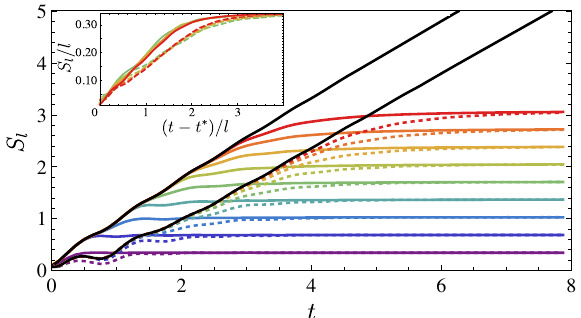
FIG. 13. Dynamics of entanglement of subsystems of size l at S ð l Þ = 2 , in TFIM for “ fast ” (solid lines) and one boundary, S l ¼ “ slow ” (dashed lines) initial states defined in the text. Different colors correspond to different subsystem sizes that range from l ¼ 1 (magenta) to l ¼ 9 (red). Black lines correspond to the entanglement entropy of a half-infinite subsystem. The data are obtained with iTEBD with truncation error ϵ < 10 − 5 . The inset shows the same data for l ¼ 5 ; … ; 9 with rescaled axes, high- lighting that the difference in entanglement spreading cannot be explained by the constant time shift and persists for largest subsystems.